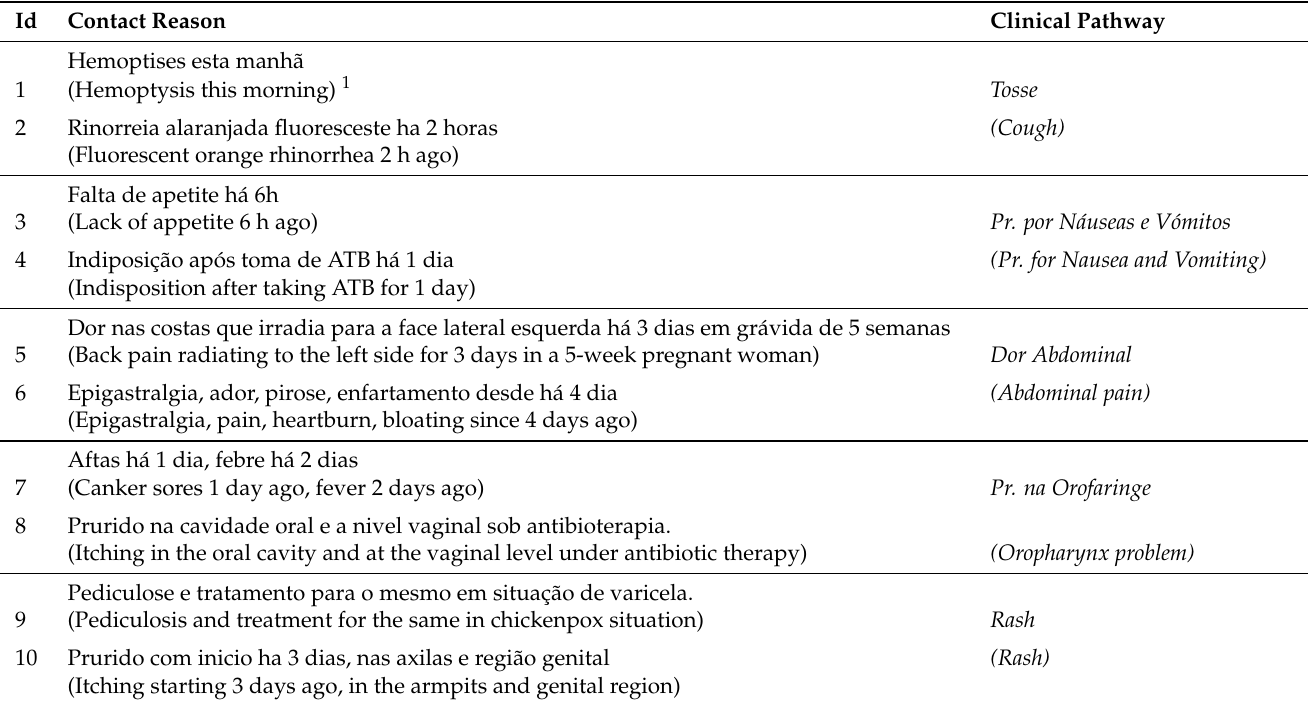
Table A2. Example texts of the “contact reason” field and their labels (“Clinical